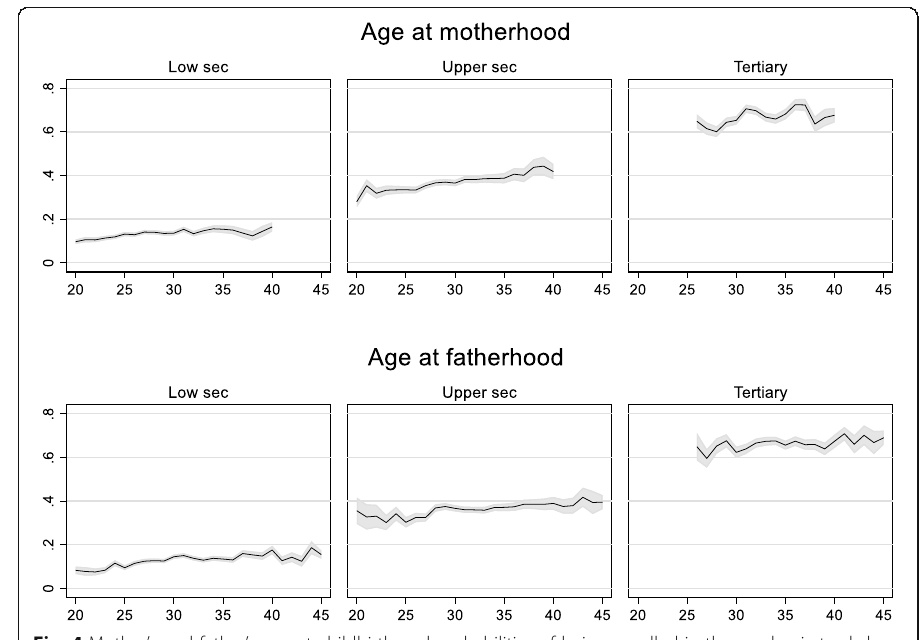
Fig. 4 Mother ’ s and father ’ s age at childbirth and probabilities of being enrolled in the academic track, by parental education. Figures show the average linear predictions (with 95% confidence intervals), from linear probability models with robust standard errors. Models control for both parents ’ social class, region of residence, trimester-year of interview, birth order, family size, birth abroad, age and